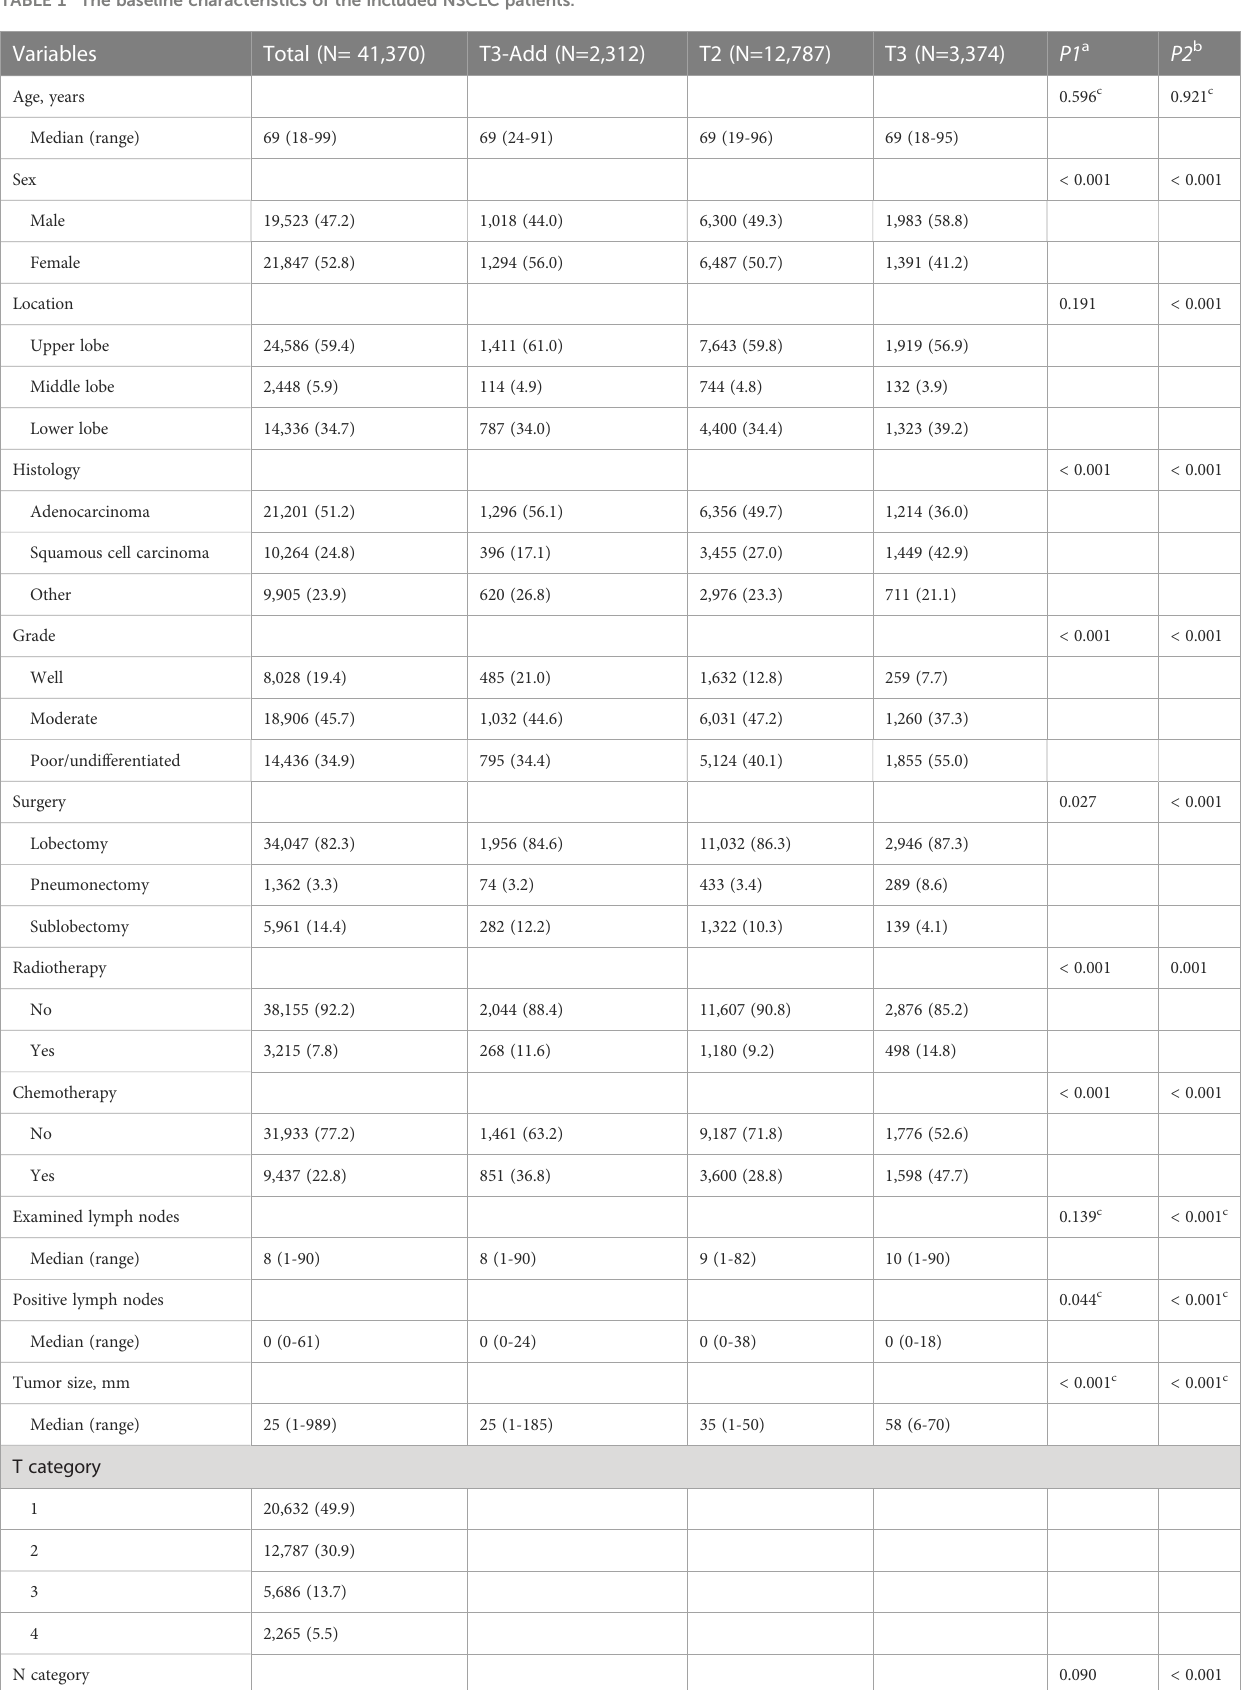
TABLE 1 The baseline characteristics of the included NSCLC